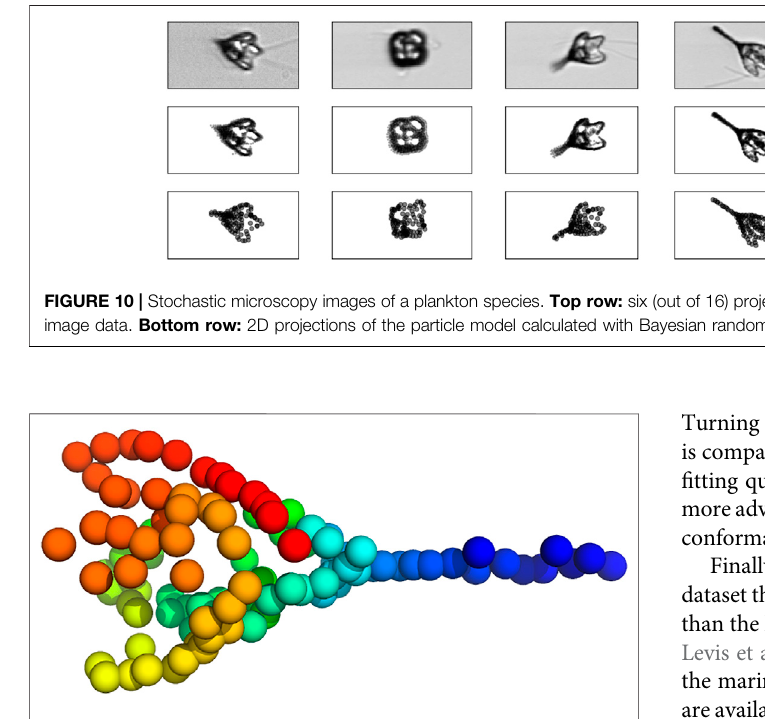
FIGURE11| 3DmodelofPyramimonasLongicaudausing 100particles inferred from the point clouds shown in Figure 10